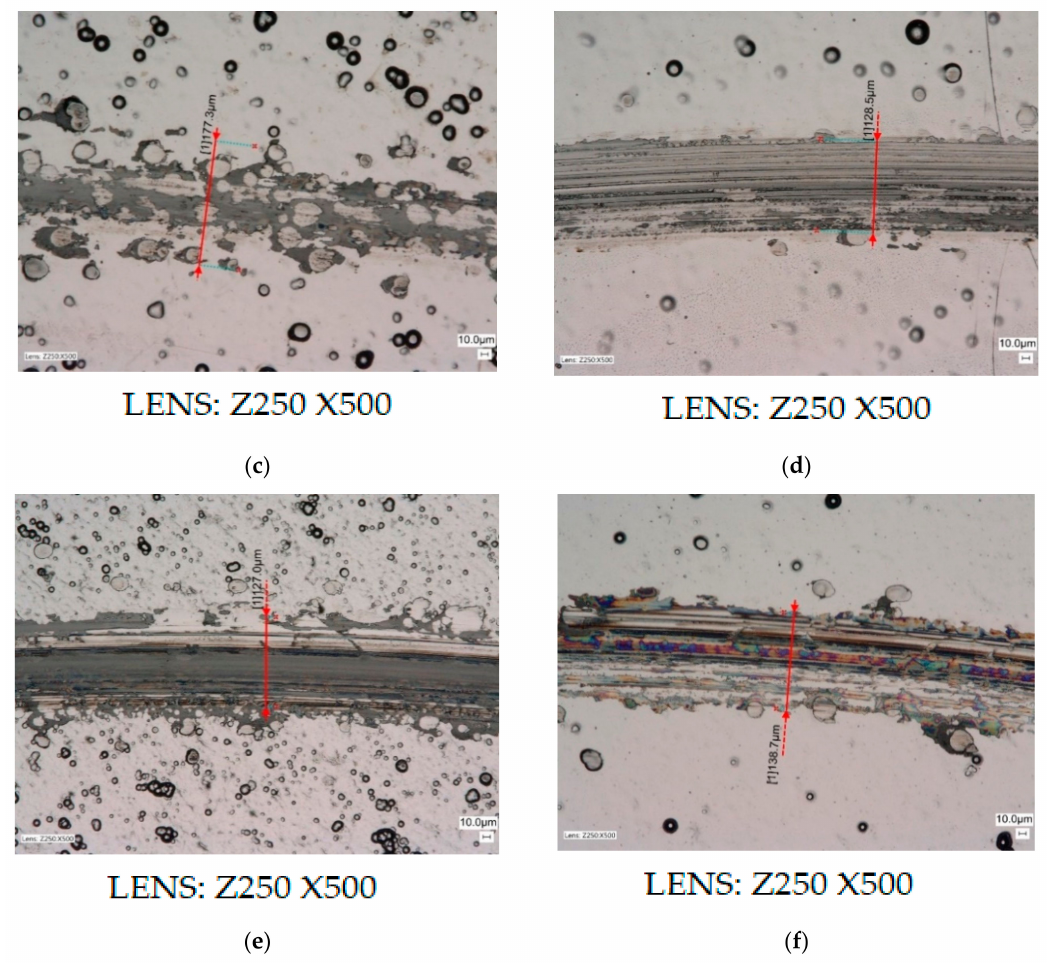
Figure 8. Samples of AW-7075 alloy without coating and with Ni-P and Ni-P / Si 3 N 4 layers (with MoS 2 grease). (( a )—AW-7075, ( b )—Ni-P (10 µ m), ( c )—Ni-P (20 µ m), ( d )—Ni-P (30 µ m), ( e )—Ni-P / Si 3 N 4 (2g), ( f )—Ni-P / Si 3 N 4 (5g); crack widths ( µ m): ( a )—813.0, ( b )—146.5, ( c )—177.3, ( d )—128.5, ( e )—127.0, ( f